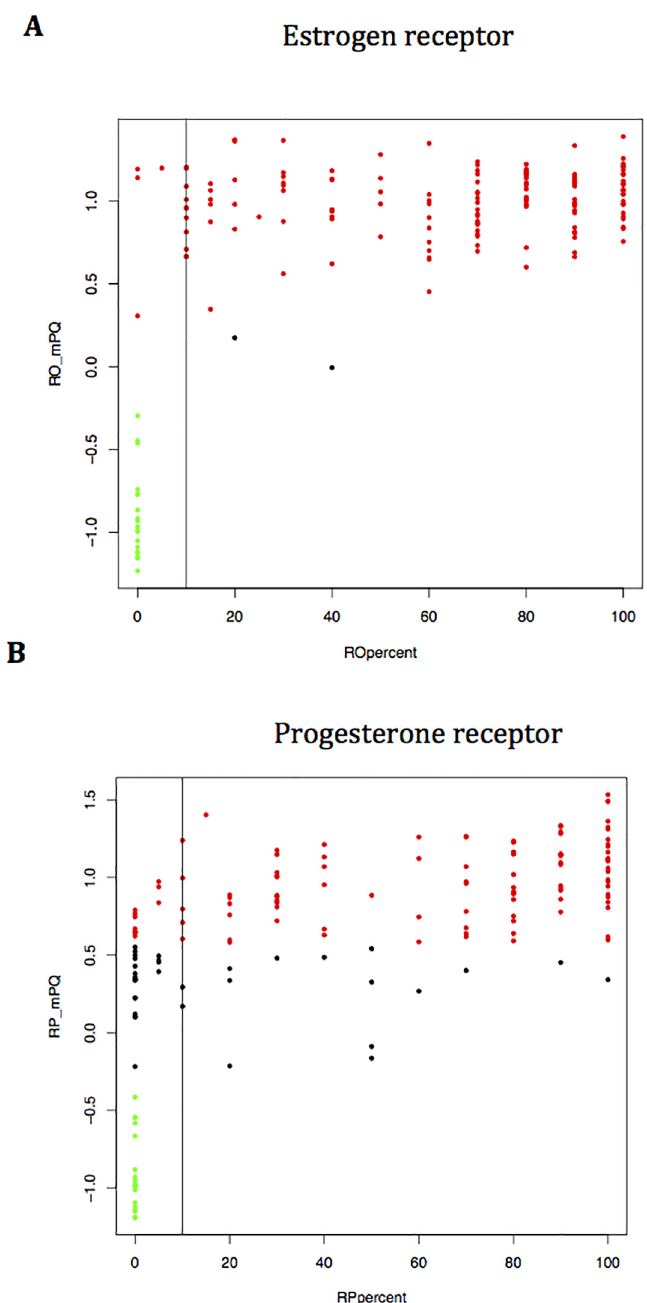
Fig 2. ER (A) and PR (B) expression by IHC and MapQuant test. Y axis: MapQuant values. X axis: Immunohistochemistry measure of ER and PR as percentage of stained tumour cells. Threshold for IHC positive sample is indicated by the vertical line (10%). MapQuant status. Green dot: negative. Black dot: equivocal. Red dot: